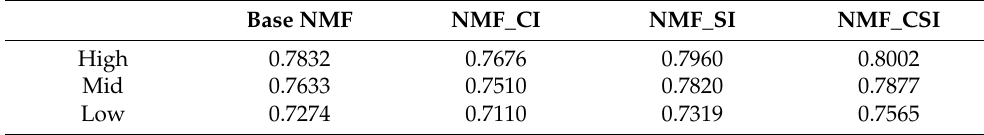
Table 3. Results by group of models reflecting domain information (HR@10).